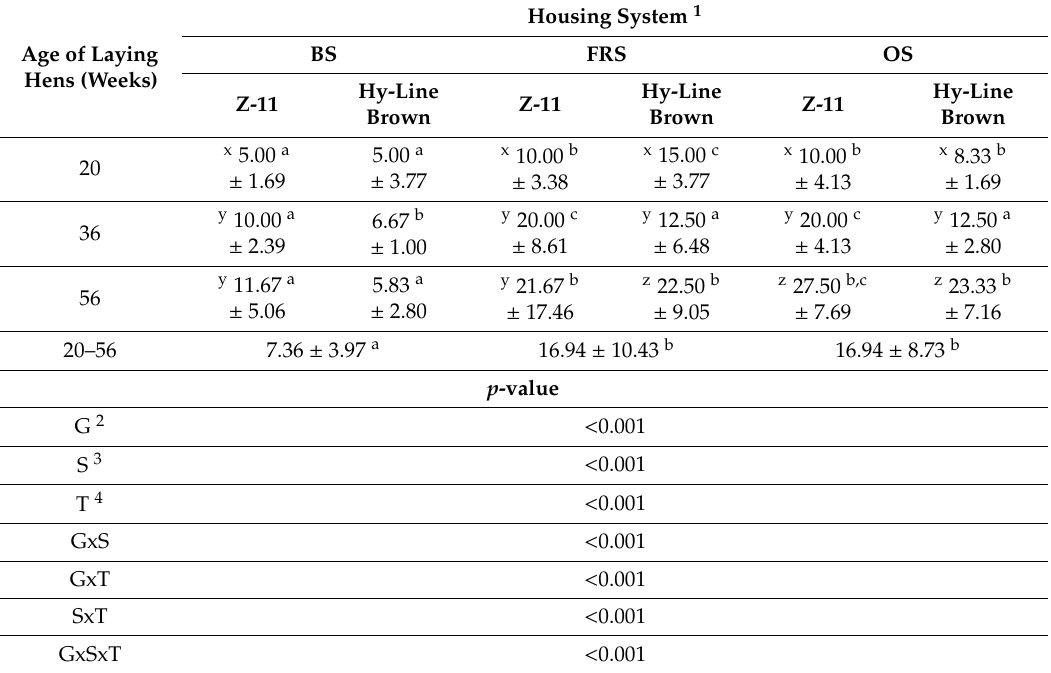
Table 3. Percentage of hens displaying comfort behaviours